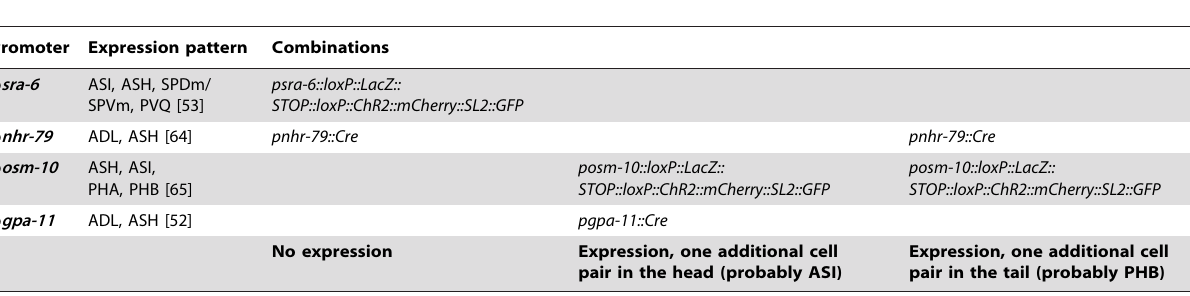
Table 2. Promoter combinations used for ASH specific ChR2 expression (Cre-lox system).